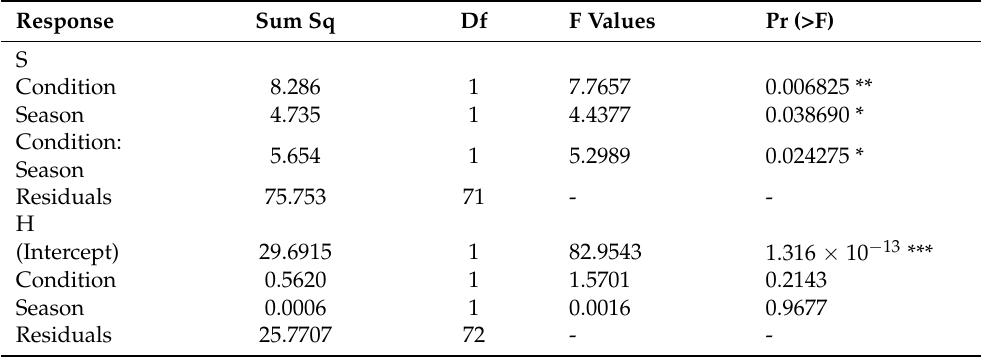
Table 2. Linear (LM) and Generalized Linear (GLM) models exploring differences in richness (S), diversity (H), dominance (C) and evenness (J) in relation to condition (aquatic/terrestrial), seasonality (rainy/dry) and interactions (condition/season).